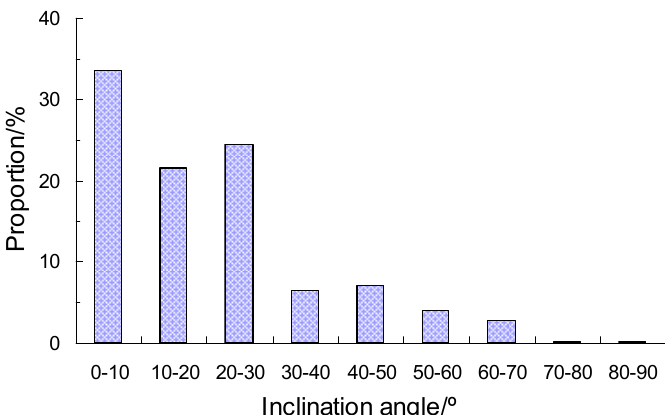
Figure 4. Statistics of the red-bed inclination angle of bedding attitude in South China.